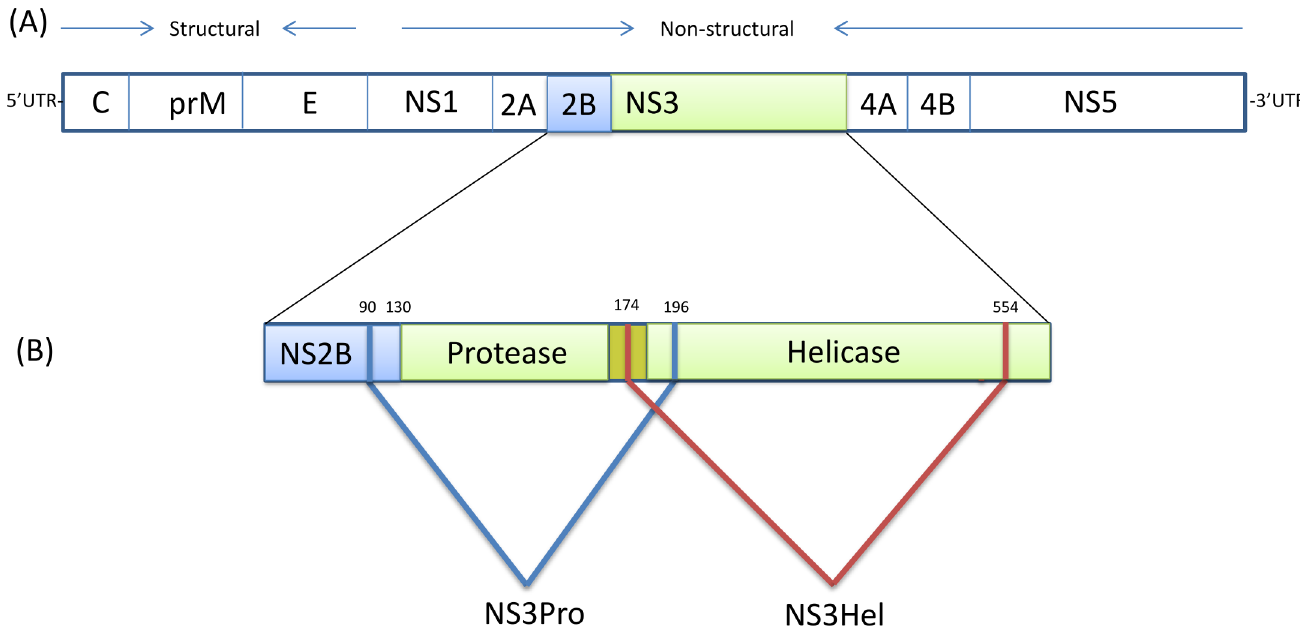
Fig 1. Schematic diagram of the DENV-2 genome (A) and the regions coded by the different recombinant plasmids (B). Dengue virus is a single- stranded, positive-sense RNA genome of about 11 kb in length. The open reading frame encodes the structural proteins capsid (C), membrane (M), envelope (E) and seven nonstructural proteins (NS1, NS2A, NS2B, NS3, NS4A, NS4B and NS5). The region linking the protease domain and helicase domain of NS3 (residues169 to 179) are shown in yellow. The last 40 residues of NS2b (90 to 130) were added to the NS3 protease (NS3Pro) fragment (1 to 196). The NS3 helicase (NS3Hel) fragment contains residues 174 to